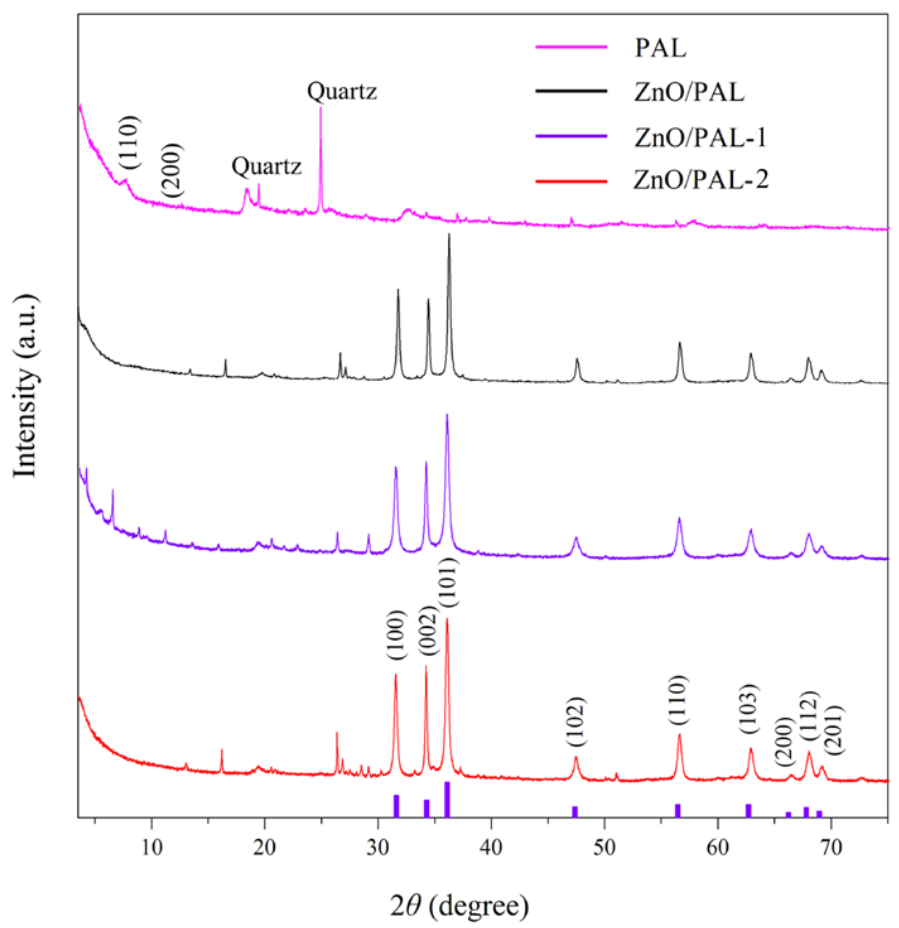
Figure 2. X-ray di ff raction (XRD) patterns of PAL, ZnO / PAL, ZnO / PAL-1 and ZnO / Figure 2. X-ray diffraction (XRD) patterns of PAL, ZnO/PAL, ZnO/PAL-1 and ZnO/PAL-2.